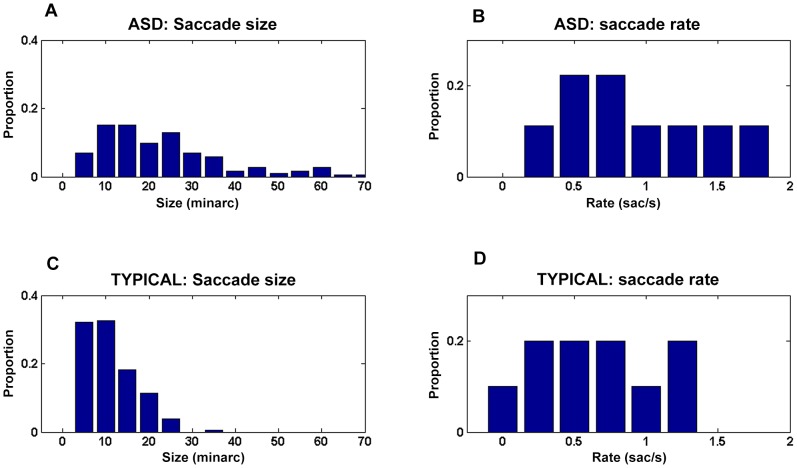
Saccades During Maintained Fixation.(A) Saccade vector sizes in ASD group (B) Saccade rates in ASD group. (C) Saccade sizes in Typical group. (D) Saccade rates in Typical group.